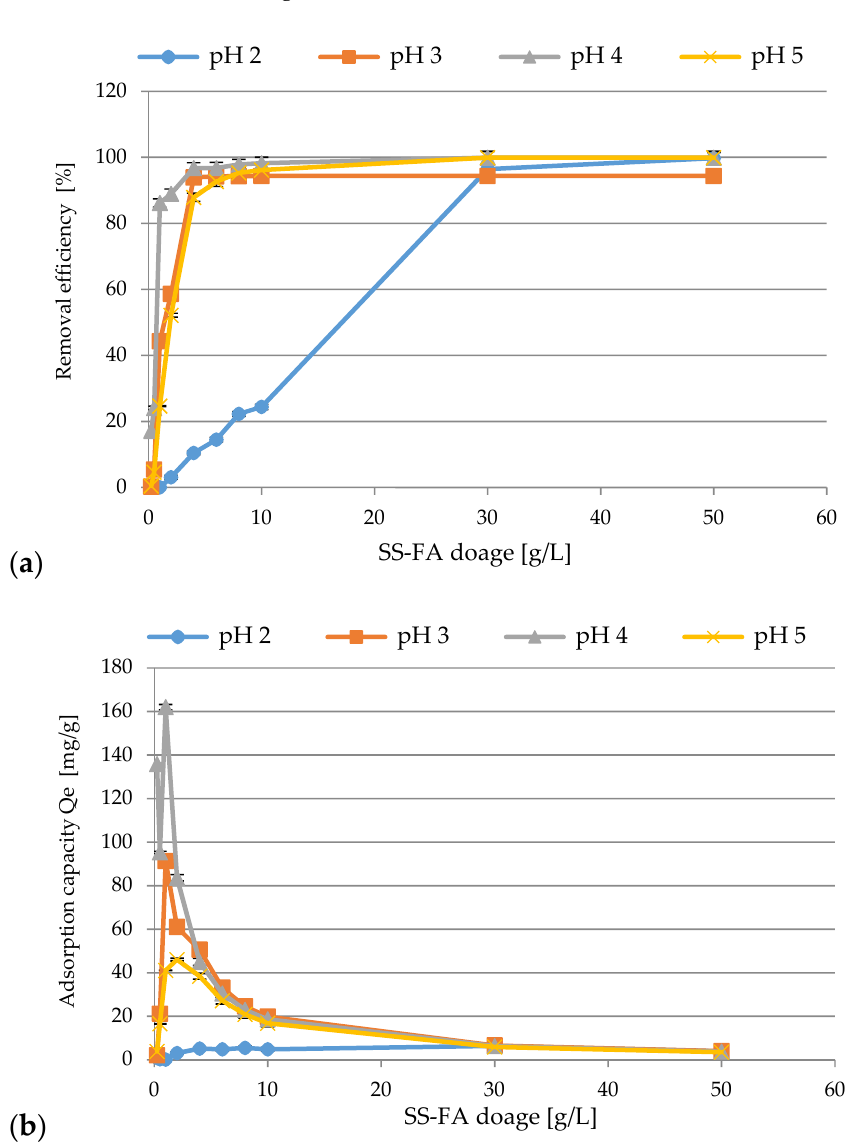
Figure 8. The effect of SS-FA dosage on adsorption efficiency ( a ) and adsorption capacity ( b ) of Ni(II) ions.